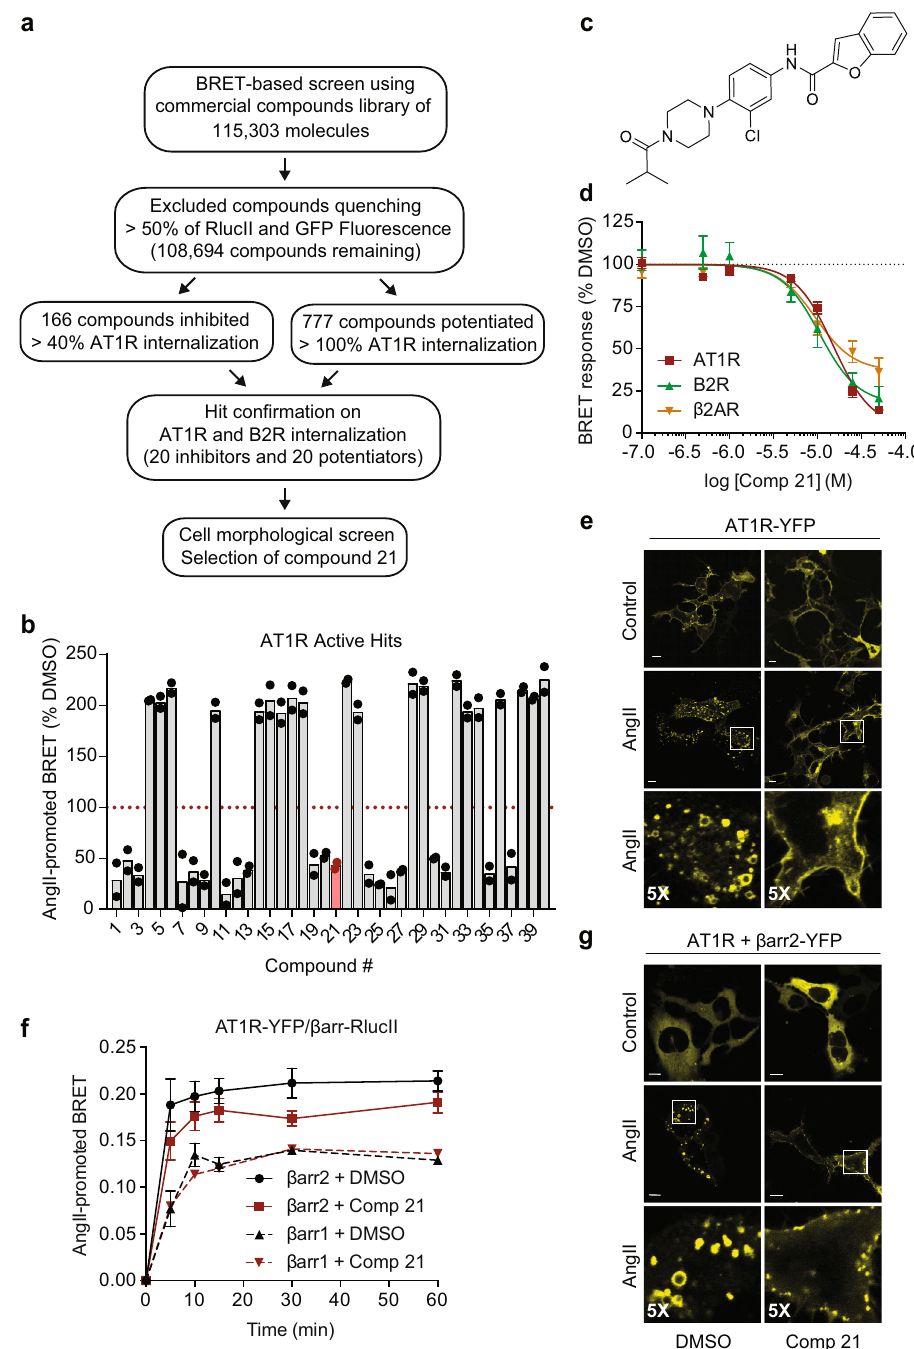
Fig. 1 High-throughput screening identi fi es compound 21 as an inhibitor of GPCR internalization. a Flowchart outlining the steps of the screening and selection of hits to the lead compound. b HTS results of 40 active hits on AT1R internalization using traf fi cking sensors. BRET responses were quanti fi ed as percent AngII-promoted BRET compared to DMSO and are presented as individual values, n = 2 biologically independent experiments. c Structure of the selected compound 21 . d Effects of 21 (50 μ M) on AT1R (closed red squares and line), B2R (closed green triangles and line), and β 2 AR (closed orange triangles and line) internalization into endosomes. BRET responses were quanti fi ed as percent ligand-promoted BRET compared to DMSO. The mean values of the ligand-promoted BRET responses (BRET ligand -BRET basal ) in DMSO were 0.260, 0.549, and 1.061 for AT1R, B2R and β 2 AR, respectively. Data are presented as the means values± SEM, n = 4 biologically independent experiments performed in triplicate. e Confocal microscopy images of YFP-tagged ATIR internalization, repeated independently three times with similar results. Scale bar = 10 μ m. Bottom micrographs are 5× enlargements of the boxed areas. f BRET recording of the recruitment of β -arrestin1 and β -arrestin2 to AT1R in the absence (DMSO, black triangles and dotted line and black circles and solid line, respectively) or presence of 21 (50 μ M, red triangles and squares, respectively, and lines). BRET responses were quanti fi ed as AngII- promoted BRET. Data are presented as mean values ± SEM, at least n = 3 biologically independent experiments performed in triplicate. Source data are provided as a Source Data fi le. g Confocal microscopy images of YFP-tagged β -arrestin2 internalization, repeated independently three times with similar results. Scale bar = 10 μ m. Bottom micrographs are 5× enlargements of the boxed